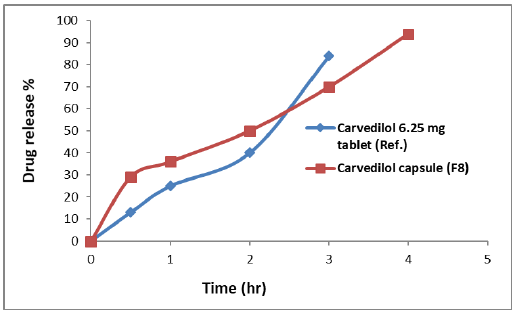
Figure 6. Drug release profile of carvedilol SPH as capsule (F8) in comparison with carvedilol